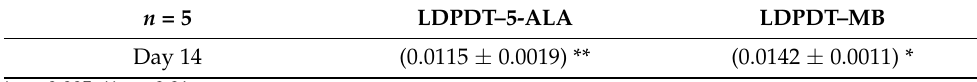
Table 2. CPF values for the studied groups (mean ± standard